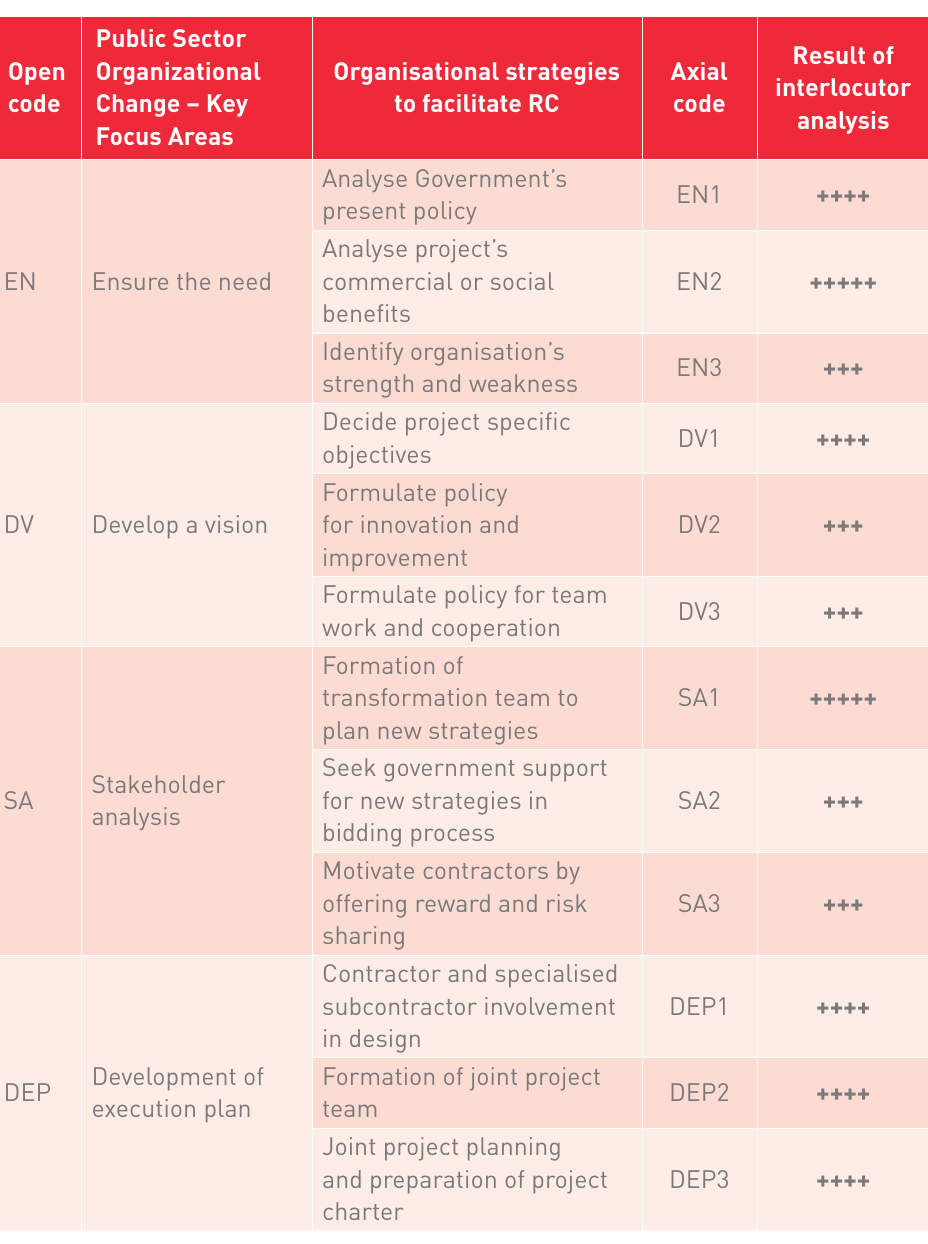
Integration of success factors for public sector change and